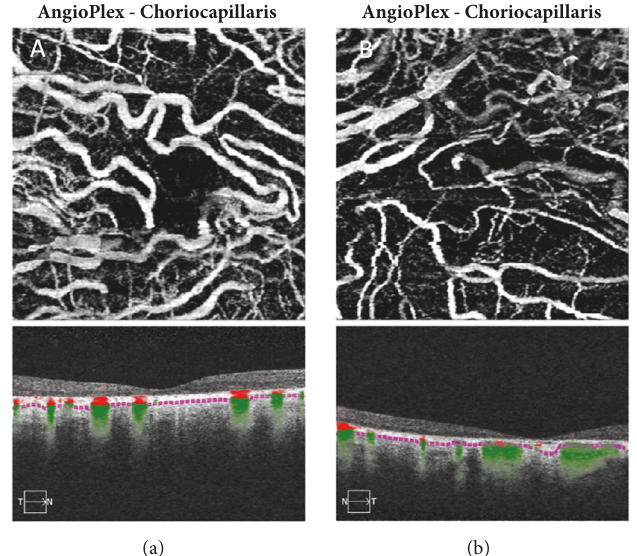
Figure 3: (a) and (b) OCTA reveals a marked decrease in choriocapillaris flow with large choroidal vessel flow present in the right (a) and left (b)